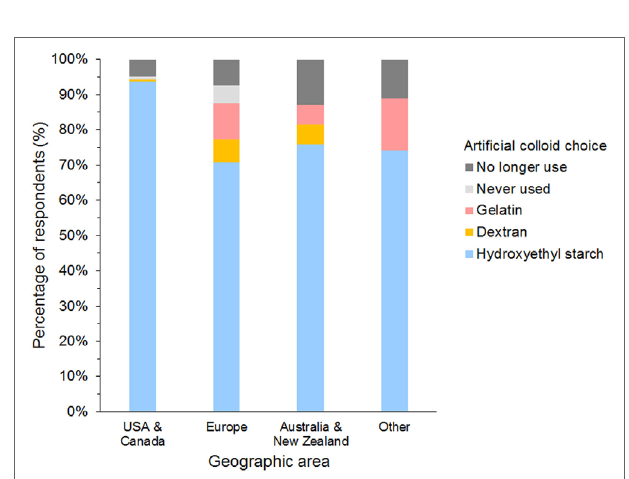
FigUre 7 | Frequency chart showing the primary synthetic colloid used by the 1,134 survey respondents from different geographic areas.